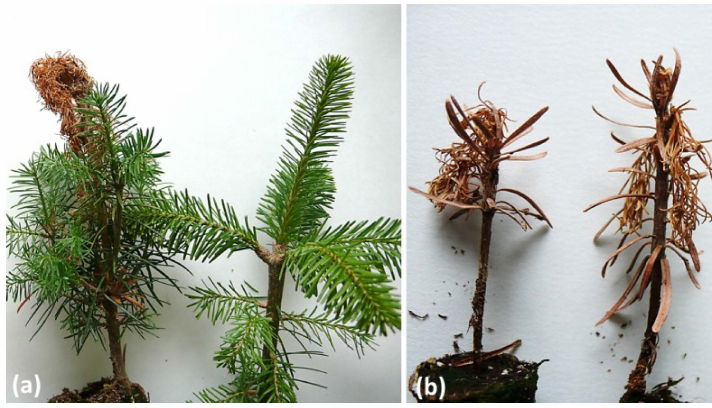
Figure 7. Plants from subalpine fir ( Abies lasiocarpa ) that were exposed to ascospores of Delphinella abietis dispersed from infected material collected in the provenance trial at Jønsberg in 2015. ( a ) Dead needles on a two-year-old plant from the provenance White River compared to a healthy control plant; ( b ) dead plants of the provenance Chuwhels Mnt. (clearly the current year shoots died at an early stage). Photos: Venche